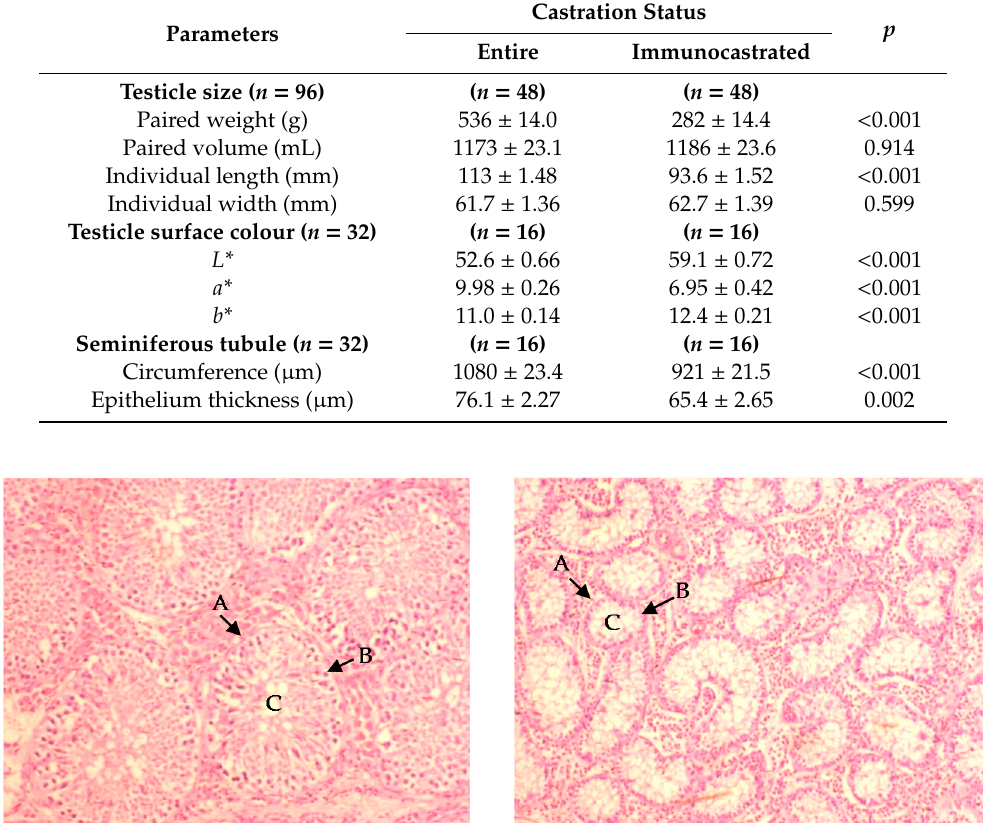
Table 4. The testicle size, CIE Lab colour value and tissue morphology traits (Least Square (LS) Mean ± Standard Error of Mean (SEM)) of immunocastrated and entire male pigs.